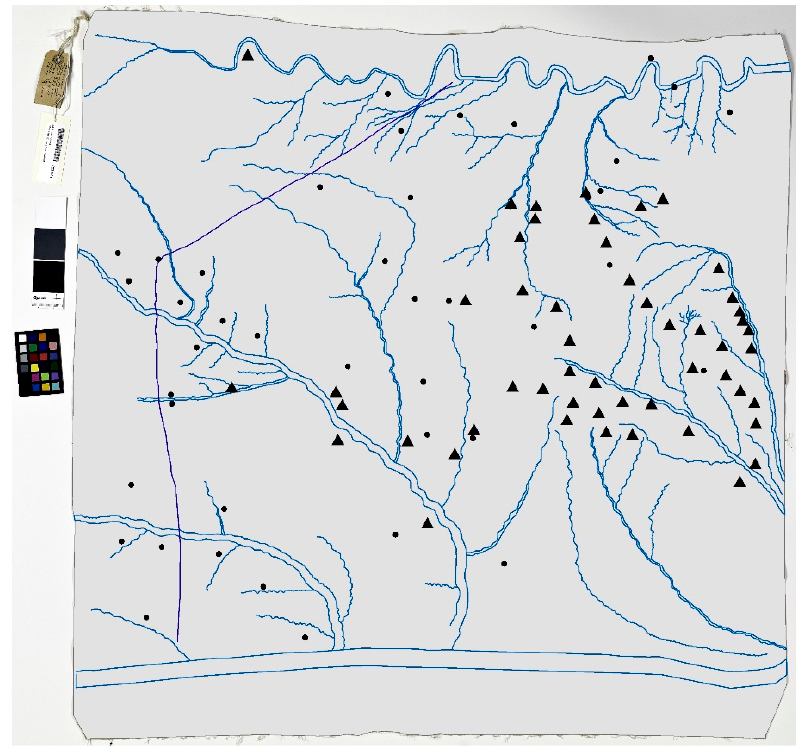
Figure 3. Digitized version of the Kiowa map. Source: Mark Palmer, University of Missouri, Department of Geography. Digitization by Lasya Venigalla.